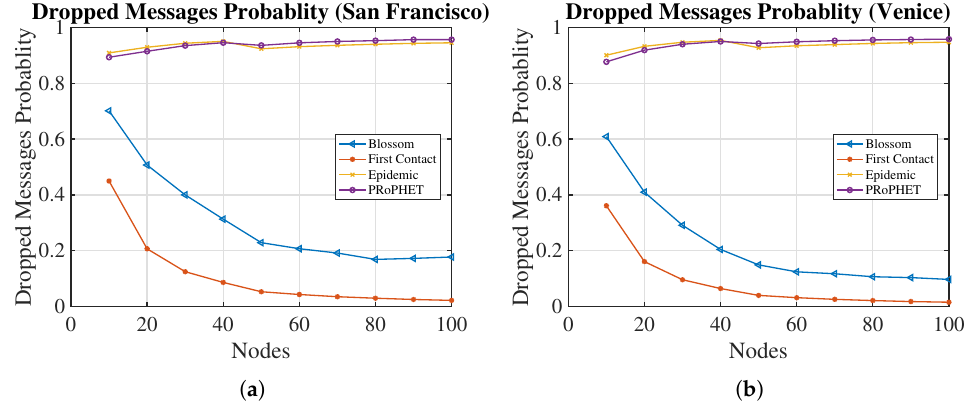
Figure 6. Comparison of routing algorithms for dropped messages’ probability. ( a ) San Francisco; ( b ) Venice.